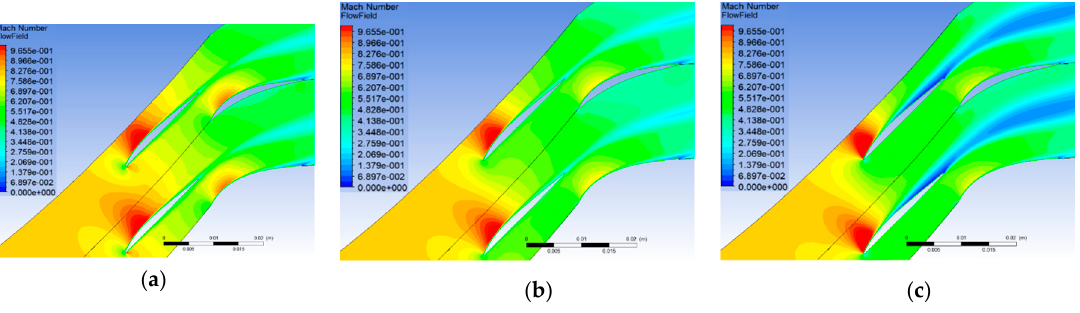
Figure 19. Optimized blade Mach contours in typical operating conditions. ( a ) i = − 5°; ( b ) i = − 1°; ( c ) i = +5°.